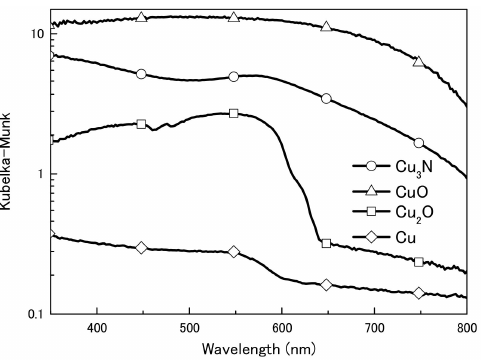
Figure 1. Ultraviolet–visible diffuse reflection spectra of copper nitride (Cu 3 N), copper(I) oxide (Cu 2 O), copper(II) oxide (CuO), and copper (Cu) particles.